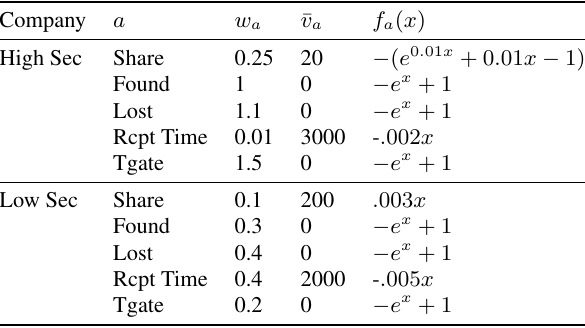
Table 1: Utility parameters